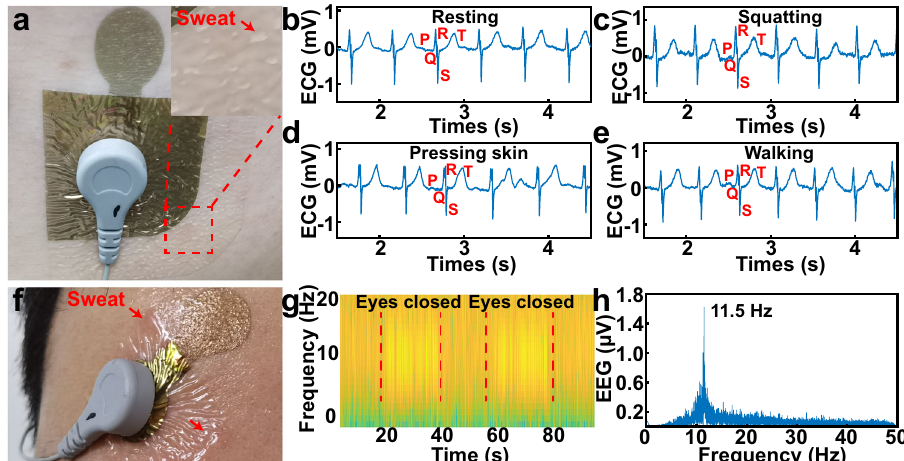
Fig. 6 ECG and EEG tests. a Photograph of the ultrathin porous electrode attached to the chest during sweating. ECG signals during resting ( b ), squatting ( c ), pressing skin ( d ), and walking ( e ) under sweating condition. f Photograph of the ultrathin porous electrode attached to the forehead during sweating. g Alpha rhythm recorded with the ultrathin porous electrode from the forehead of a volunteer during sweating. h Alpha rhythm centered at ~11.5